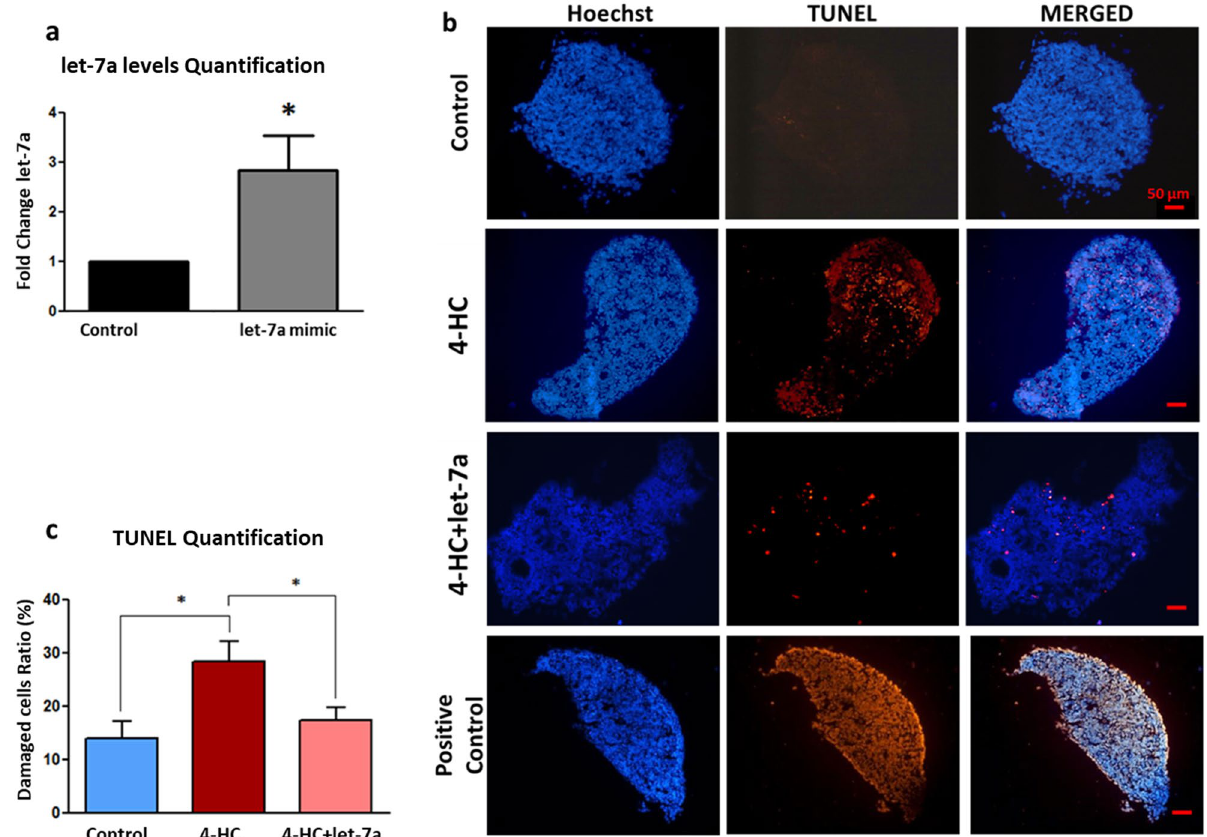
Figure 1. ( a ) Increased expression of let-7a in PND3 ovaries after transfection with let-7a mimic using liposome delivery system (N = 3). ( b ) DNA-damage/apoptosis assessment in PND3 ovaries after 2 days culture in three different conditions: control, 4-HC, and 4-HC + let-7a. Ovarian sections show nuclear labelling with Hoechst (blue) and DNA-damaged/apoptotic cells /TUNEL positive (red) (scale bar; 50 µm). The transfection with let-7a mimic reduced chemotherapy-induced damage. ( c ) The quantification of damaged cells was performed in at least three different ovarian sections (N ≥ 3) for each experimental group (N = 7). Each result is presented as the mean, the error bars represent the standard error, * p <